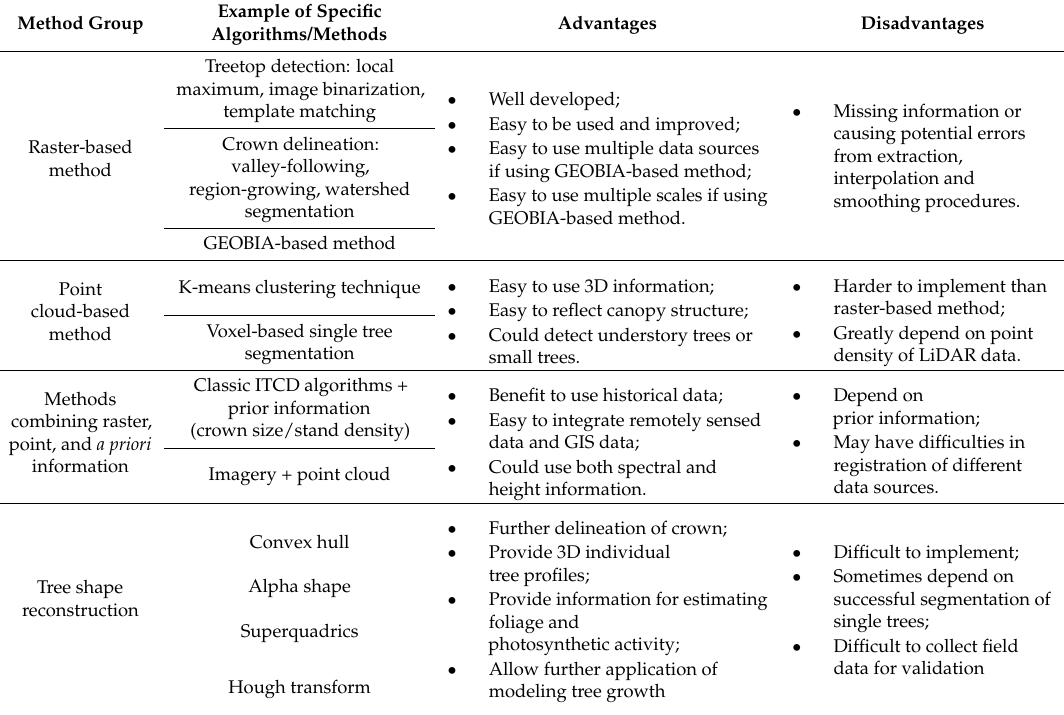
Table 2. The characteristics of the four methods using LiDAR data for ITCD.